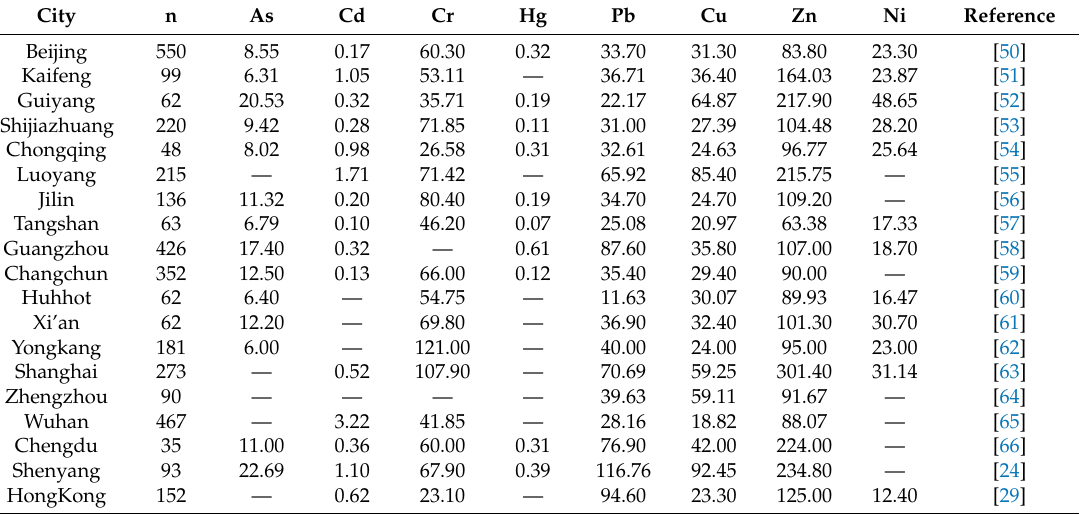
Table 3. The concentrations of heavy metals in urban soils around China (mg /